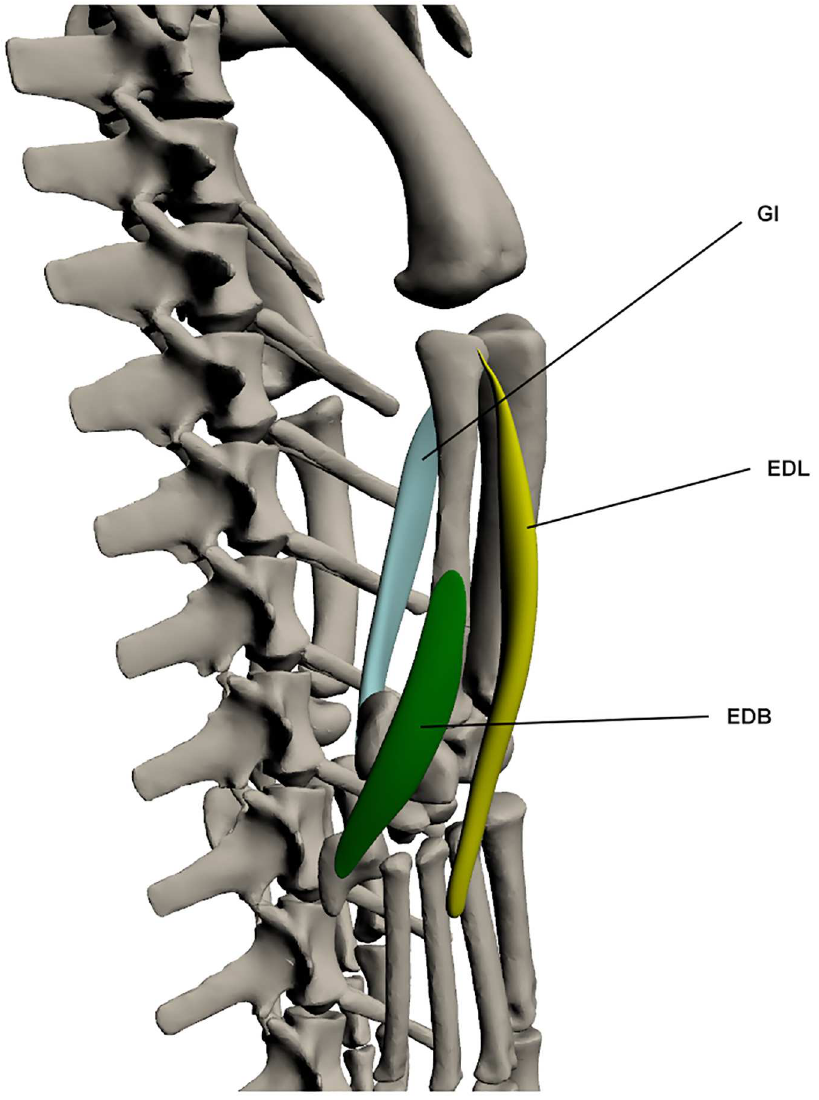
Fig 18. Superficial ventral muscles of the lower hindlimb. GI: Gastrocnemius internus ,EDL: Extensor digitorumlongus , EDB: Extensor digitorumbrevis .